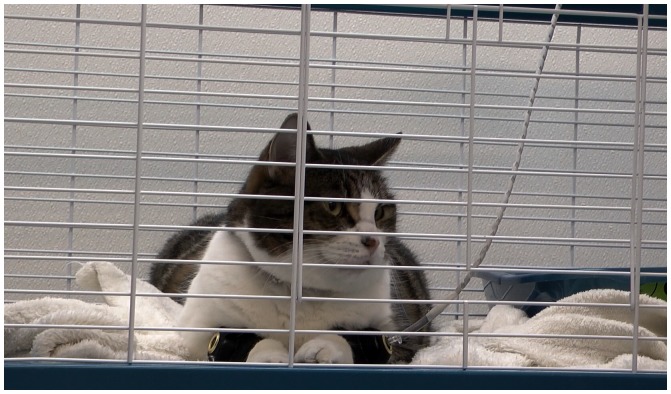
Photograph of the mechanical repetitive stimuli quantitative sensory testing experimental setting.Cats were placed in a meshed cage. The mechanical stimulator, which was embedded in a small band, was placed around the distal aspect of the cat's foreleg (left in this photograph) and connected to the stimulator device, while a dummy band was installed on the contralateral leg (right in this photograph).